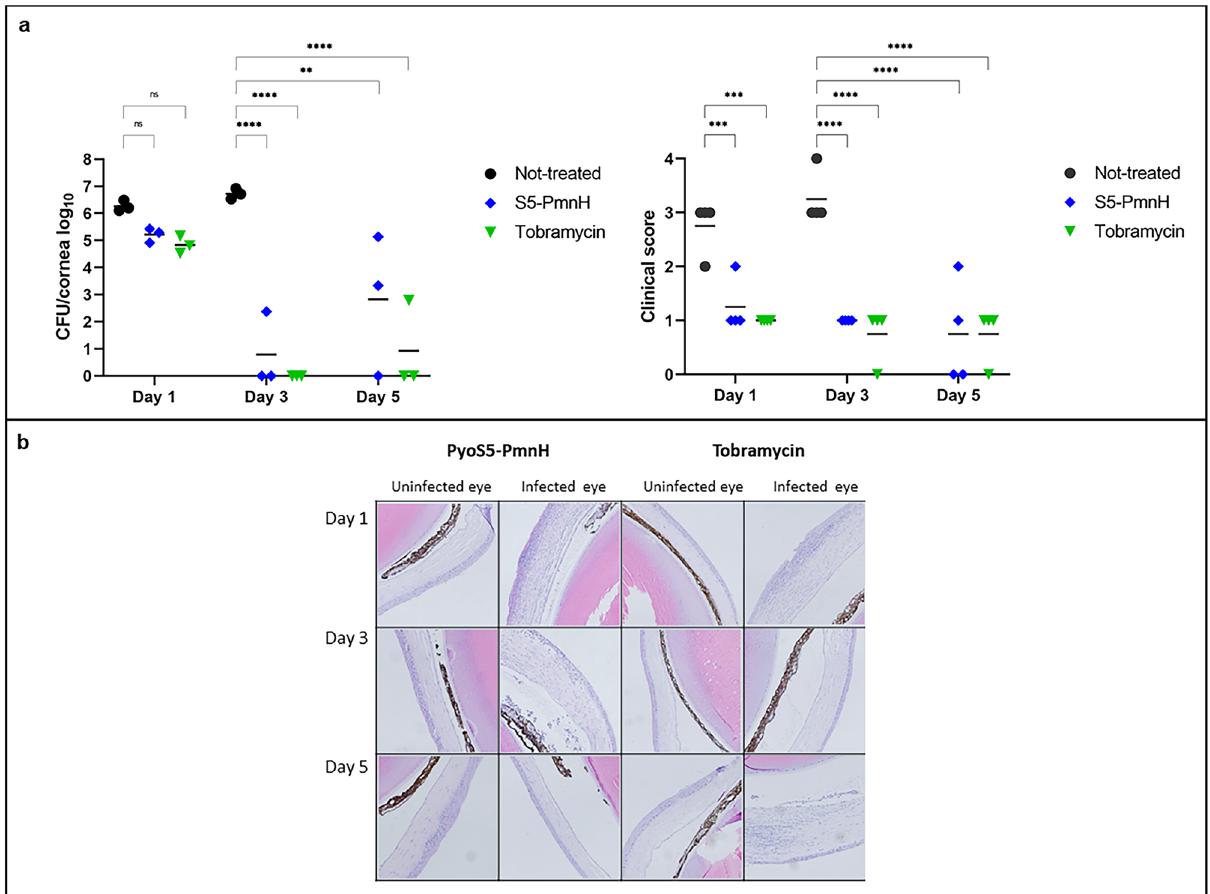
Figure 6. Mice cornea infection by invasive strain PAO1 and treatment by S5-PmnH or tobramycin. The corneas of left eye of mice were infected with 4 × 10 6 CFU of P. aeruginosa PAO1 strain. The treatment with 20 µg of S5-PmnH or 140 µg of tobramycin started 6 h post-infection and was applied twice daily. ( a ) CFU counts in mice corneas and cornea clinical scores at 1, 3 and 5 dpi. ( b ) Hematoxylin–eosin staining of cornea sections. Uninfected eyes: no marked aberrations, weak edema in corneal stroma observed in most samples. Infected S5-PmnH-treated eyes: days 1 and 3—acute inflammation of cornea, day 5—no aberrations. Infected tobramycin-treated eyes: Day 1—acute inflammation of cornea, local cornea lesions, Day 3—thinning of cornea epithelium, strong edema of the corneal stroma; day 5—local inflammation of cornea, thinning and degeneration of cornea epithelium. Statistical significances of the quantitative data were analyzed using GraphPad Prism software by the 2-way repeated measures ANOVA and Dunnett’s correction for multiple comparisons. Mean is indicated by horizontal bar. **P ≤ 0.01, ***P ≤ 0.001, ****P ≤ 0.0001 vs vehicle-treated mice. Not significant (ns) P >